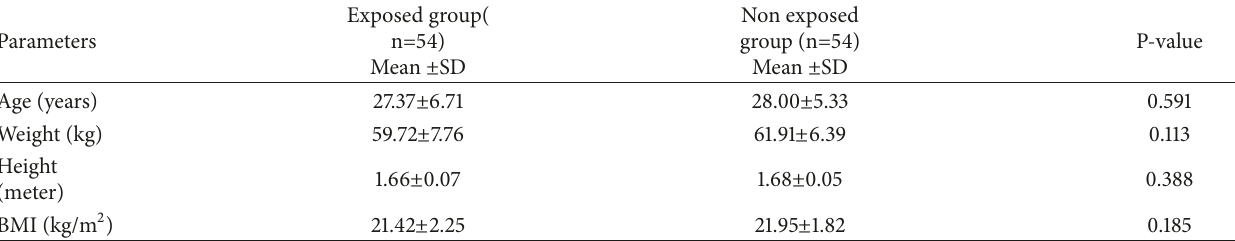
Table 2: The anthropometric measurements for flour mill workers and control groups by independent sample t-test.